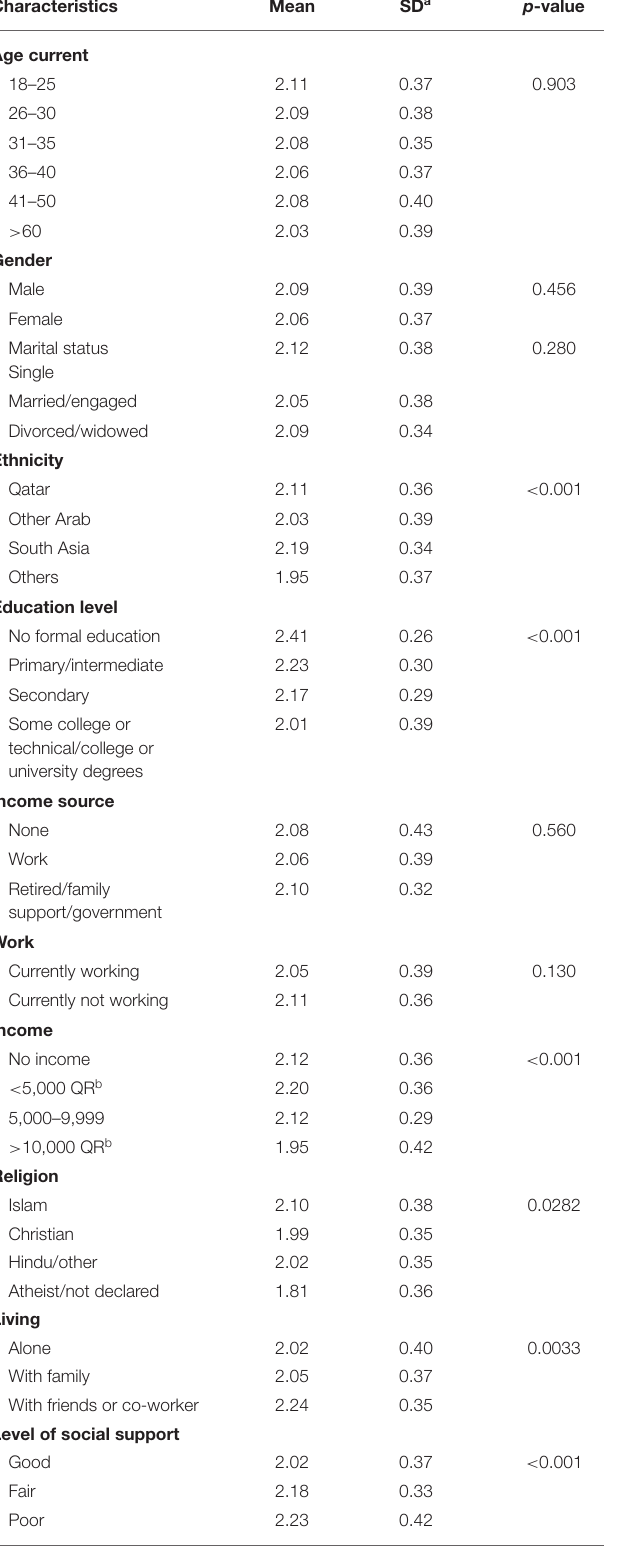
TABLE 4 | Association between mean stigma scores and patients’ characteristics.